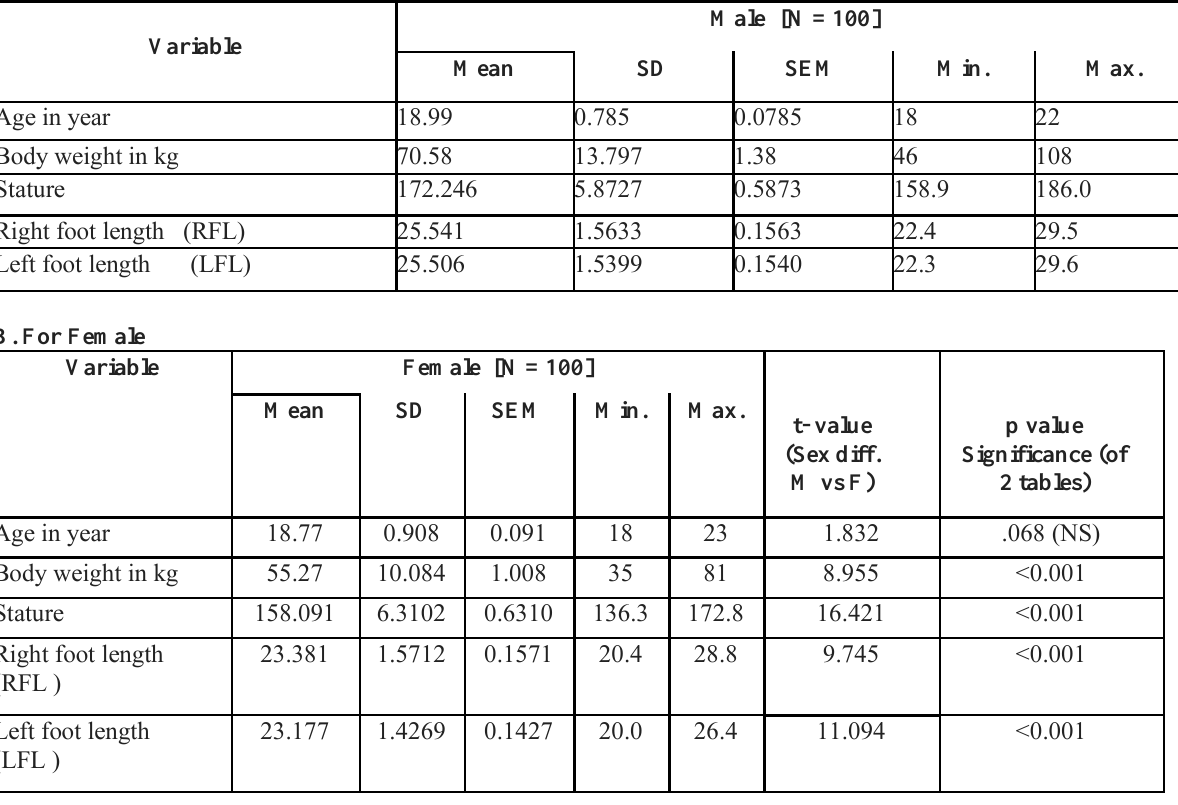
Table 1. Descriptive statistics for stature and measurements (in cm) of feet in male and females.